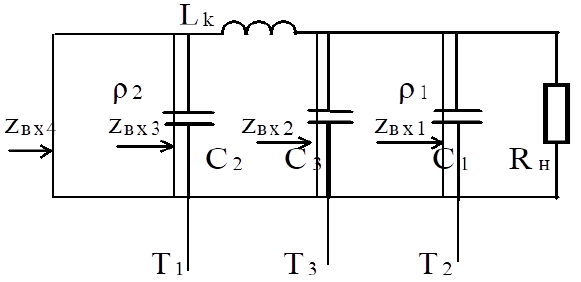
Figure 5. Equivalent load circuit with compensating inductance L k .